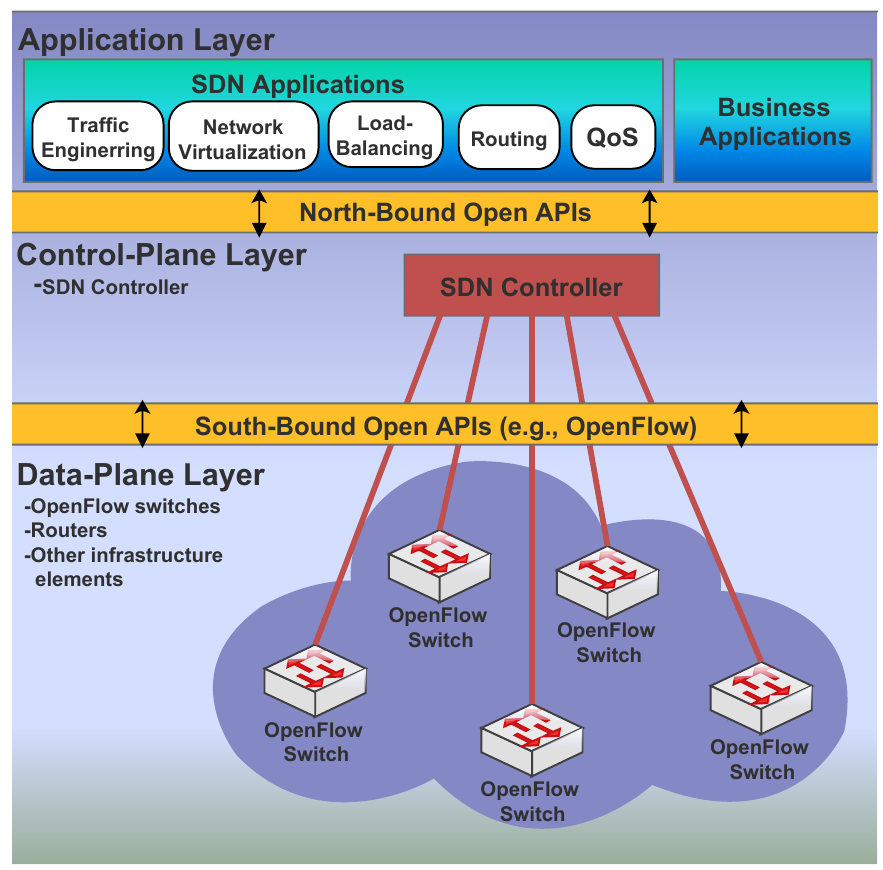
Figure 2. Overview of software defined networking (SDN) architecture with its main planes: data, control, and application planes, and the communication channels